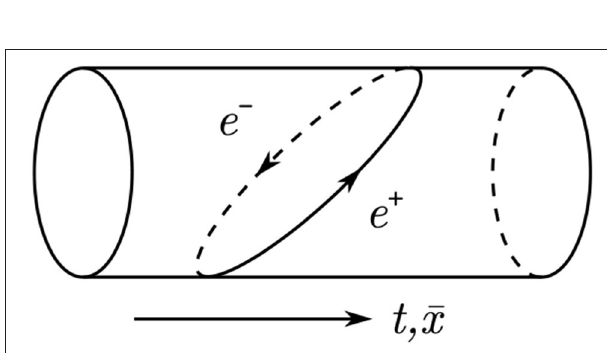
significantly non-zero are much smaller than their